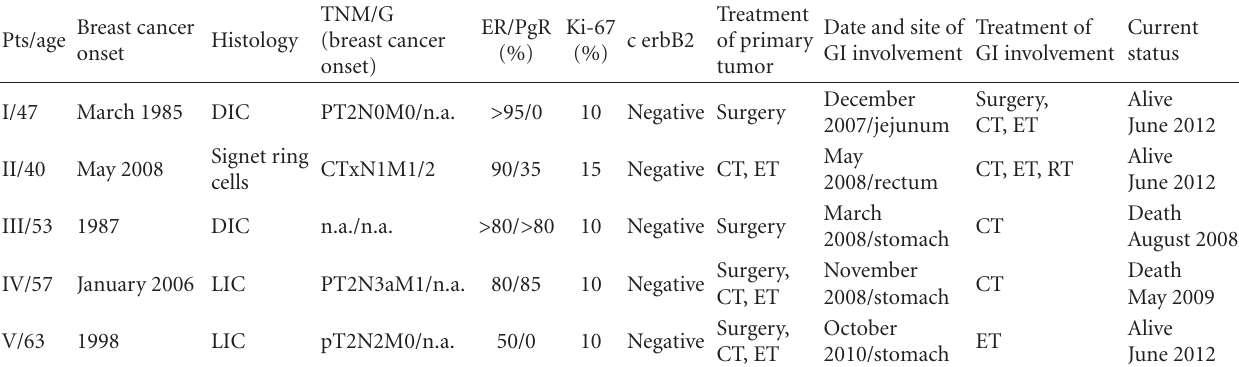
Table 1: Clinical characteristics of patients with breast cancer and GI tract